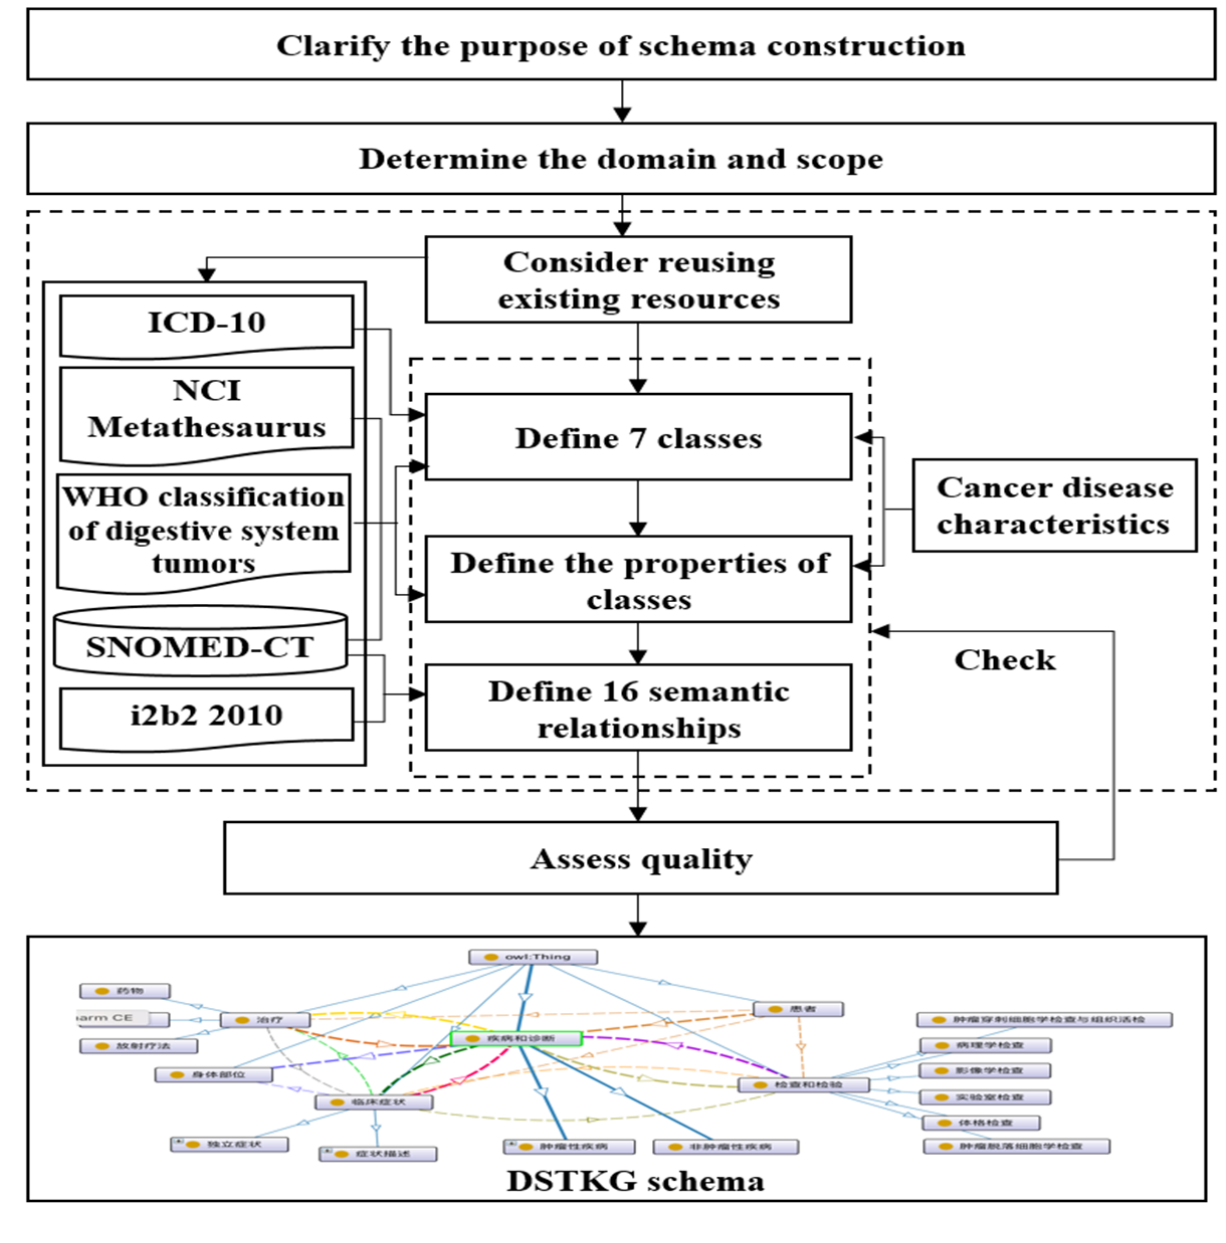
Figure 2. Process of constructing the digestive system tumor knowledge graph (DSTKG) schema. i2b2: Systematized Nomenclature of Medicine-Clinical Terms; ICD: International Classification of Diseases; NCI: National Cancer Institute; SNOMED CT: Systematized Nomenclature of Medicine-Clinical Terms; WHO: World Health Organization.